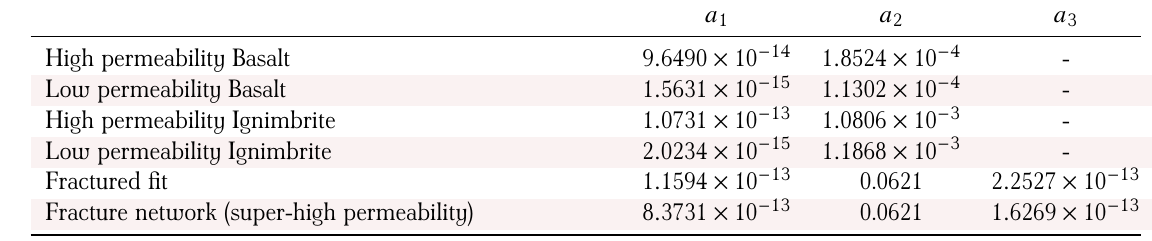
exp (− 𝑎 ; 𝑧 = 0 m, 𝑧 = 1500 m. 𝑧 ) + 𝑎 Min Max 1 2 3